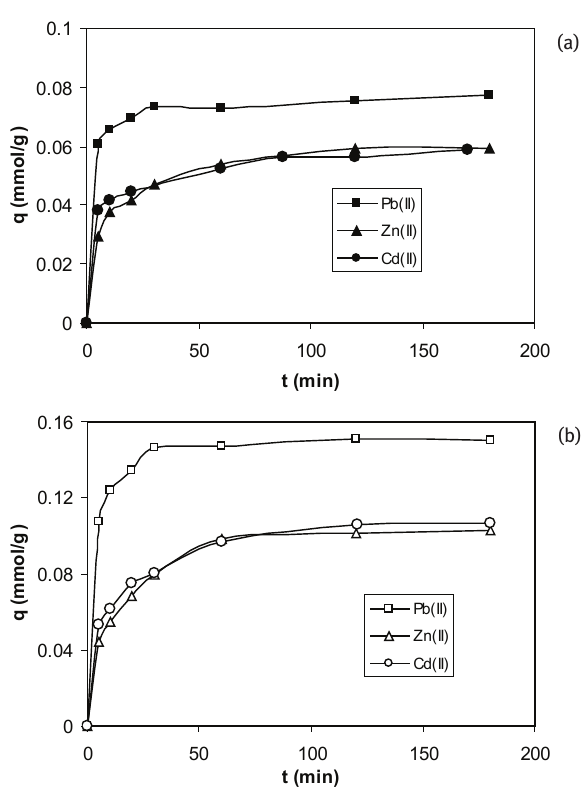
Figure 4: Effect of contact time on heavy metal biosorption onto mustard waste biomass (pH = 5.5; biosorbent dose = 5 g/L; c 0.41 mmol M(II)/L (a) and 0.85 mmol M(II)/L (b); t = 20